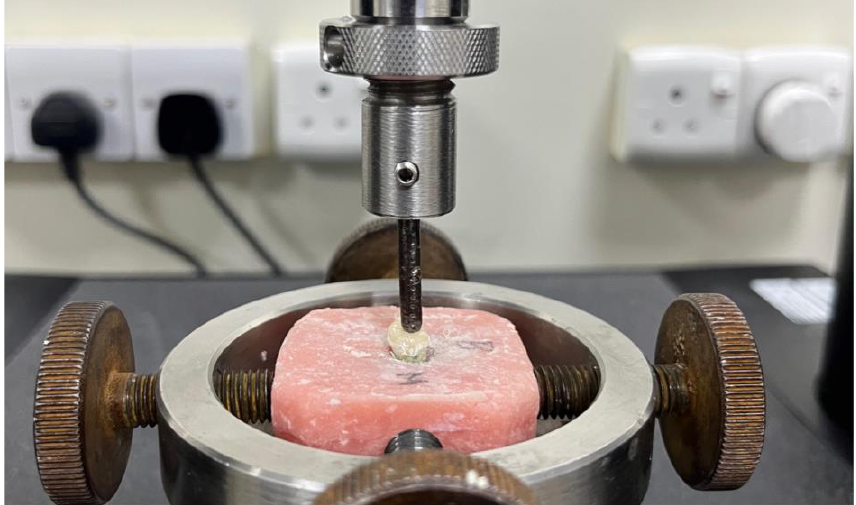
Figure 3. Specimens were placed into fixtures mounted of the universal testing